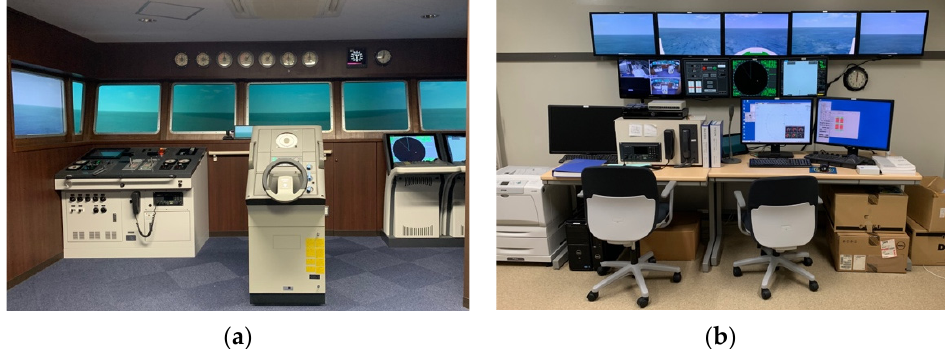
Figure 2. Ship handling simulator: ( a ) wheelhouse; ( b ) setting room of the simulating condition.